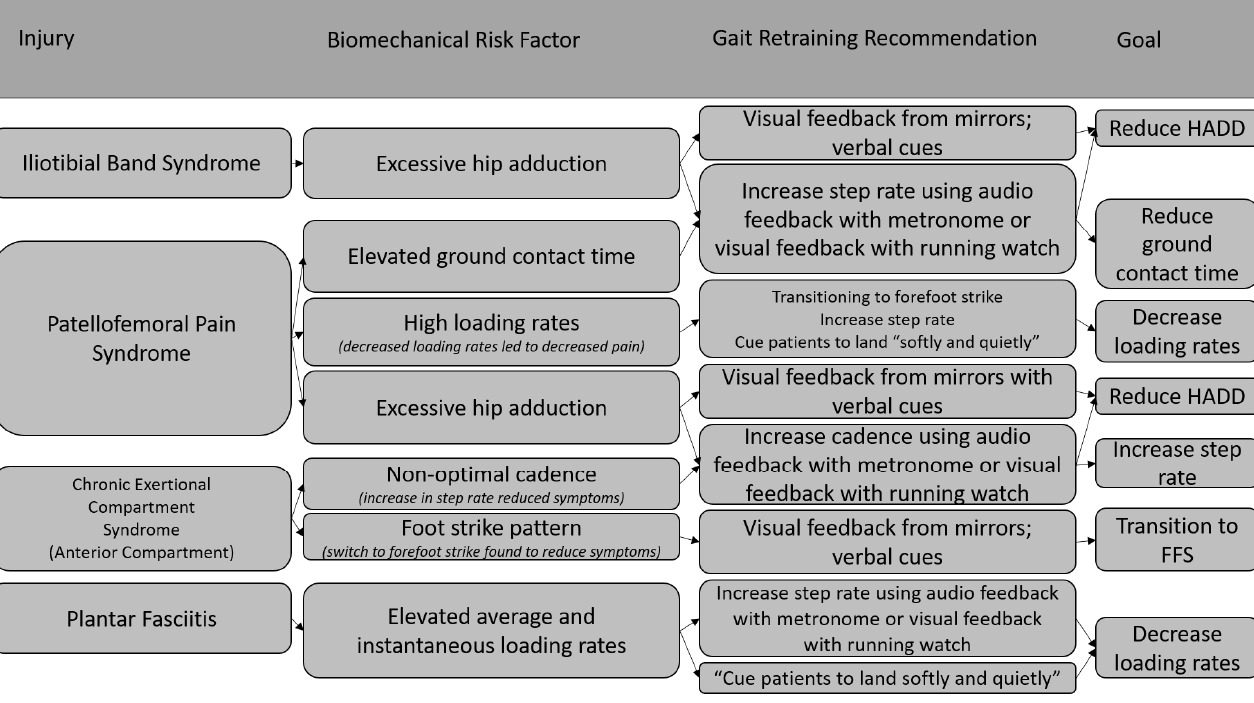
Figure 2. Examples of using gait retraining to treat other specific RRIs [28,29,32–35,42,46,63–67].